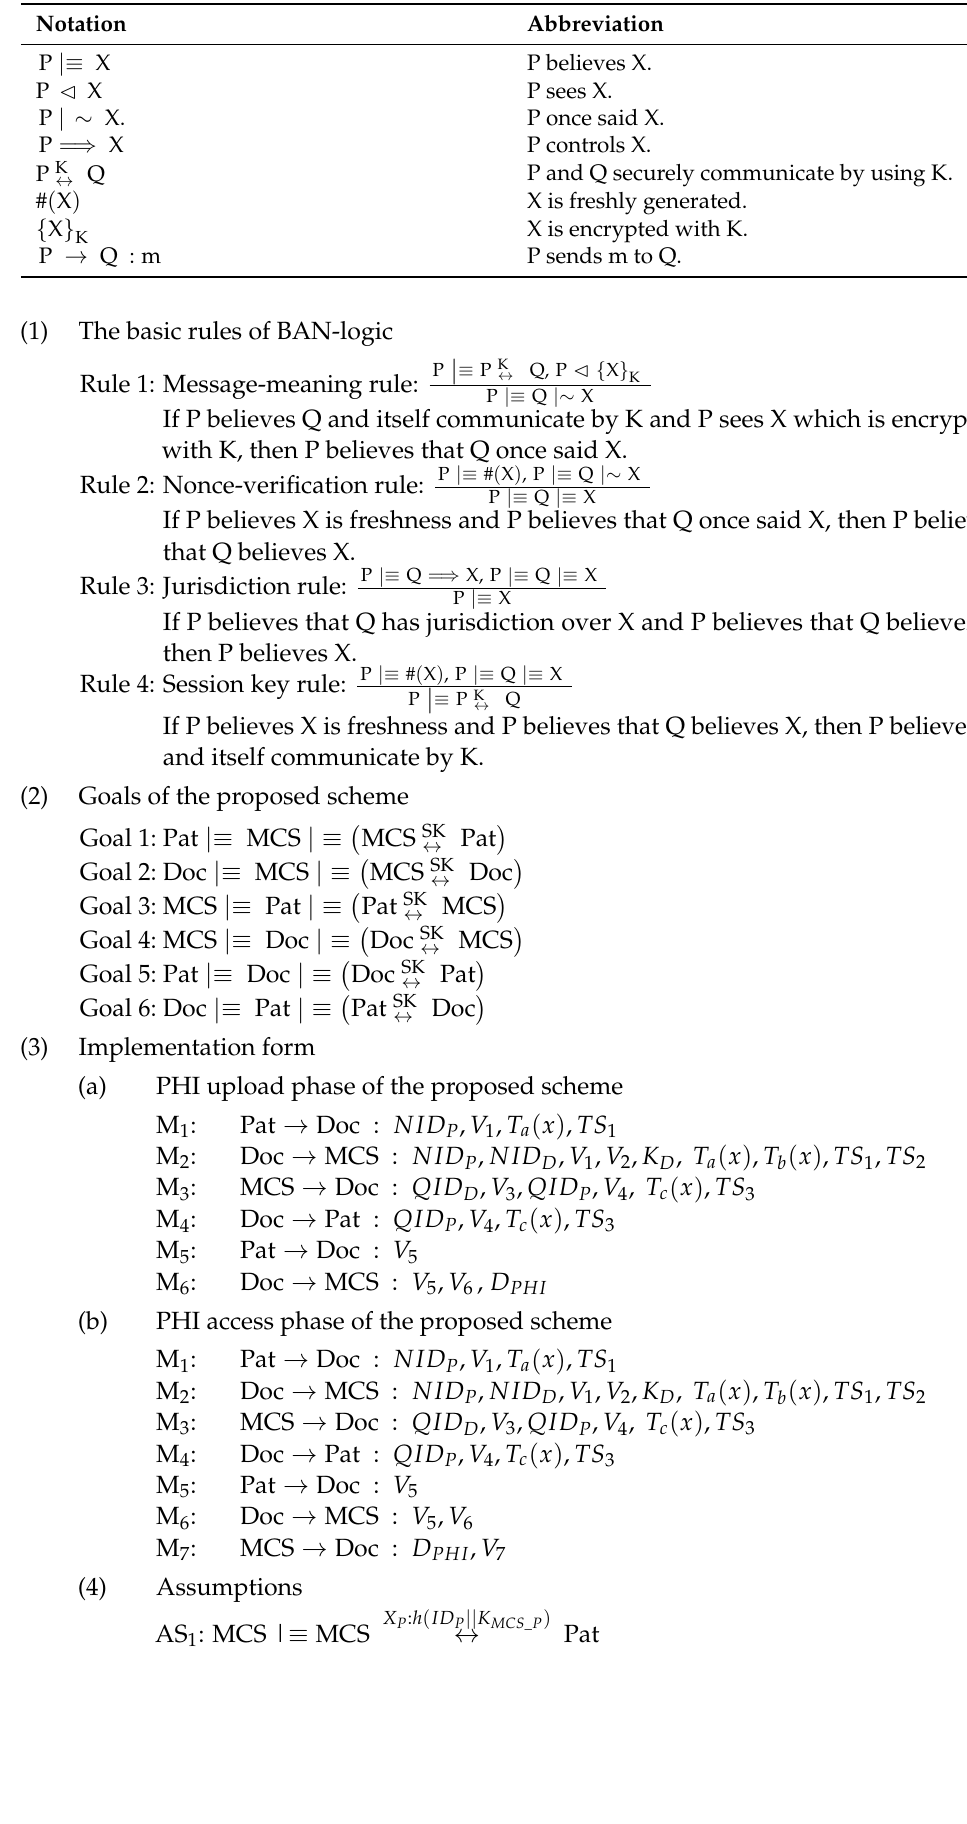
Table 2. Notations and abbreviations of the BAN-logic